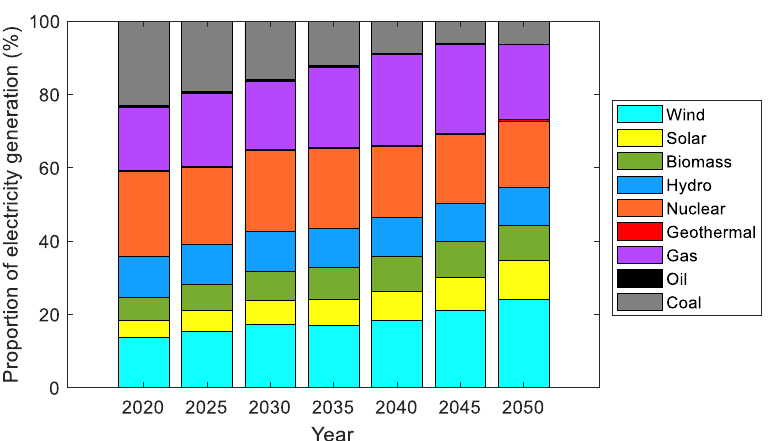
Figure 8. Electricity generation projection compiled from European Commission data [64].